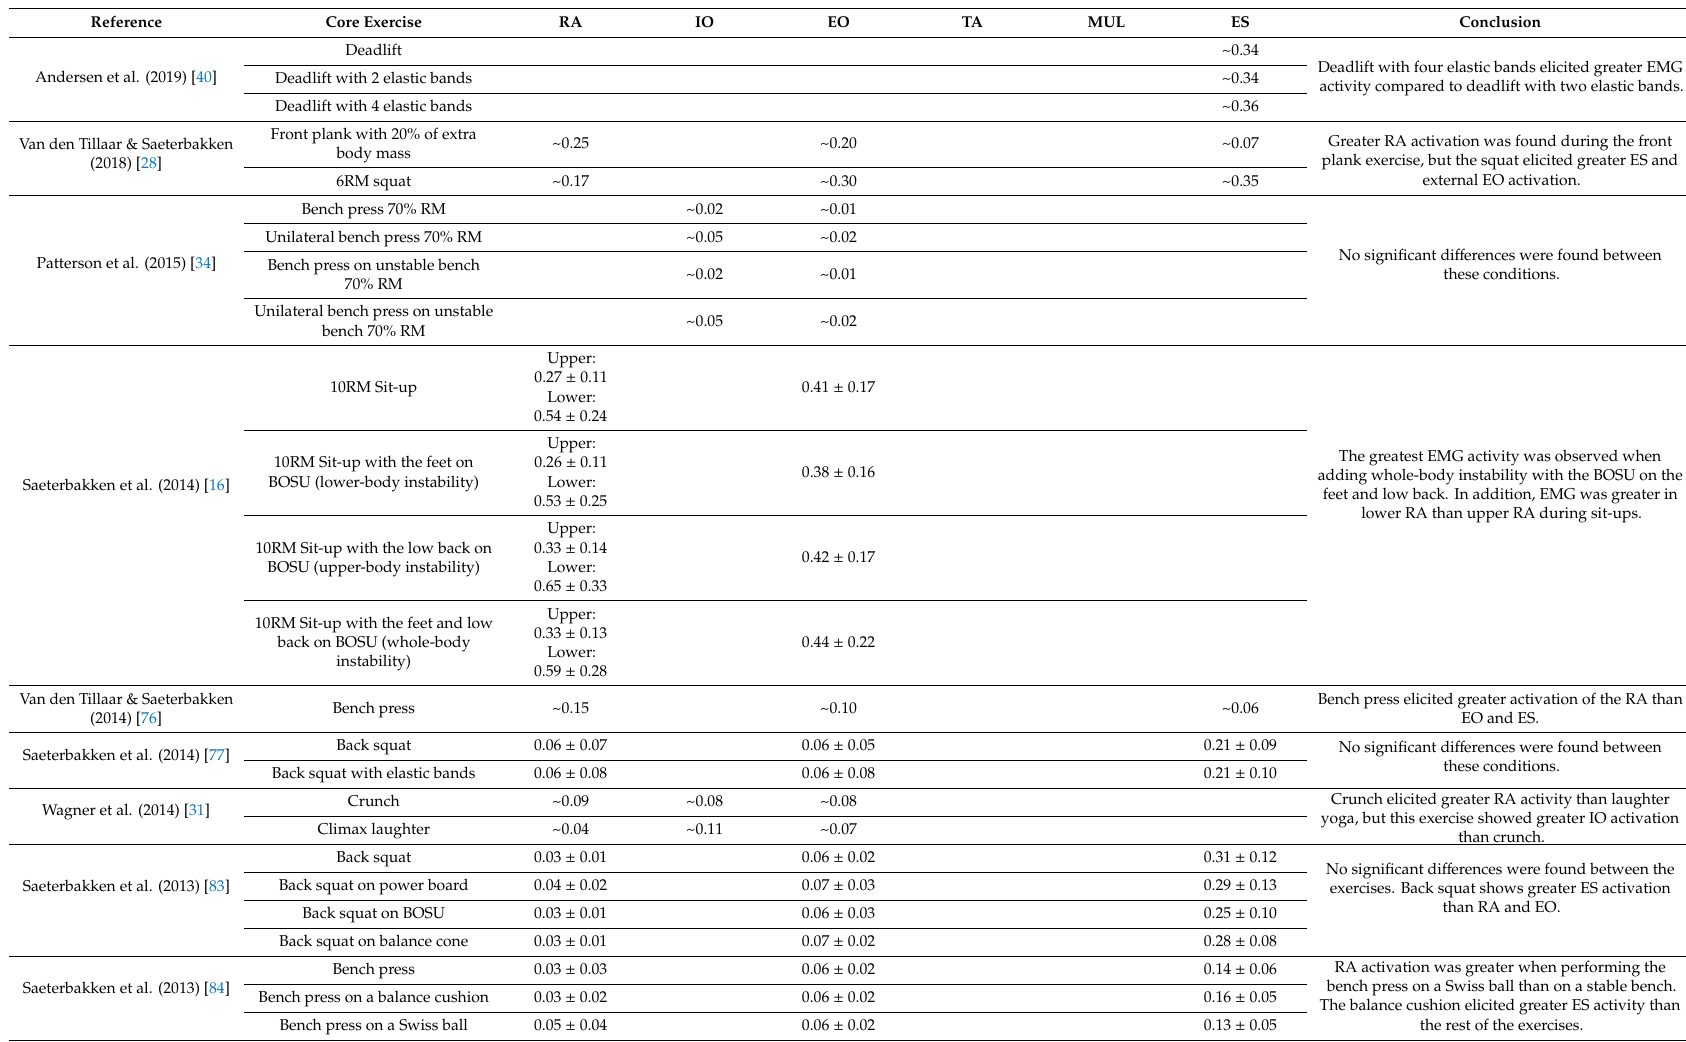
Table 4. Descriptive statistics of electromyographic activity (expressed as millivolts, mV) in each study by